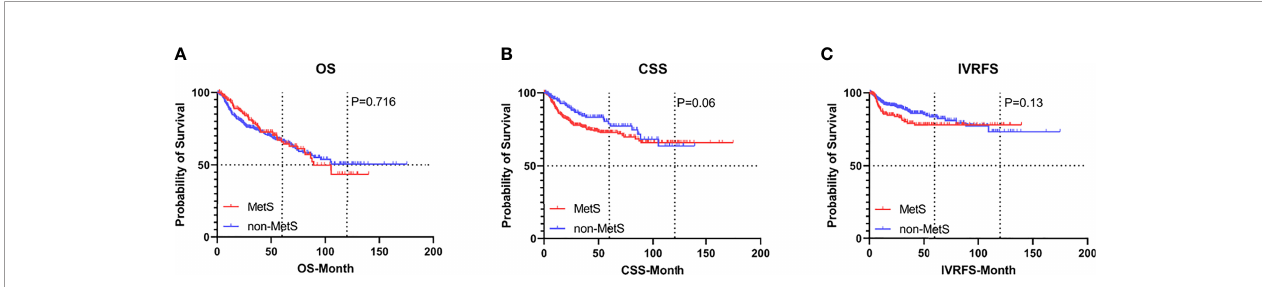
FIGURE 2 | Kaplan-Meier curves for survival outcomes in UTUC patients according to the presence of MetS before propensity score matching. (A) OS, (B) CSS, and (C) IVRFS. OS, overall survival; CSS, cancer-speci fi c survival; IVRFS, intravesical recurrence-free